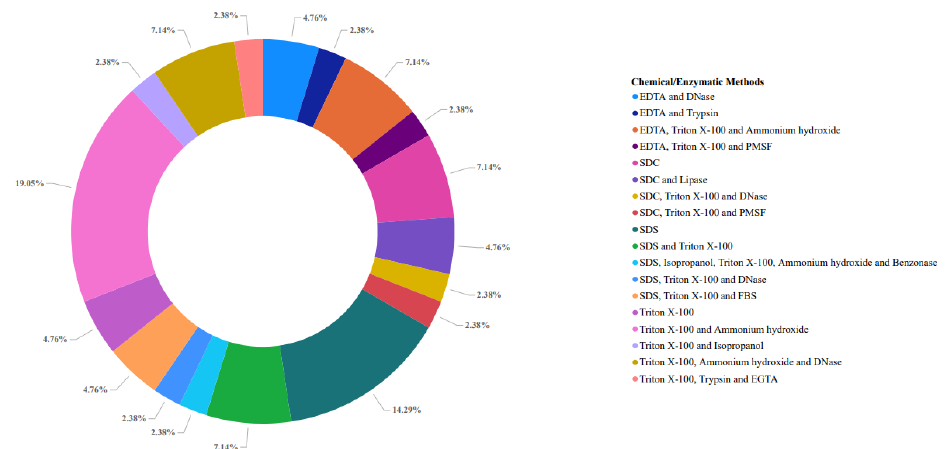
Figure 3. Chemical/enzymatic methods for pancreas decellularization found in the PubMed database between 2009 and 2021. The most used method to date includes the use of Triton X−100 and ammonium hydroxide (17.39%), followed by the use of only SDS (13.04%), while the rest of the studies addressed the use of different types of detergents (ionic and non-ionic) simultaneously in the decellularization process.